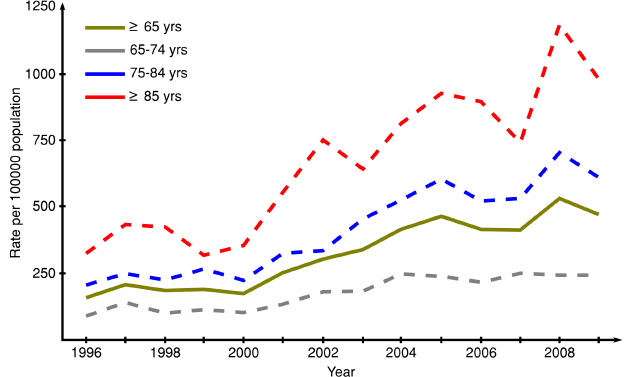
Figure 2. Increases in C. difficile infection over time. Graph includes patients aged 65 years and older who were either hospitalized with CDI or who acquired C. difficile during a hospital stay. Rates for 1996–1999 were based on U.S. Census Bureau civilian population estimates adjusted for the net underenumeration in the 1990 census. Rates for 2000–2009 were calculated using U.S. Census Bureau 2000-based postcensal civilian population estimates